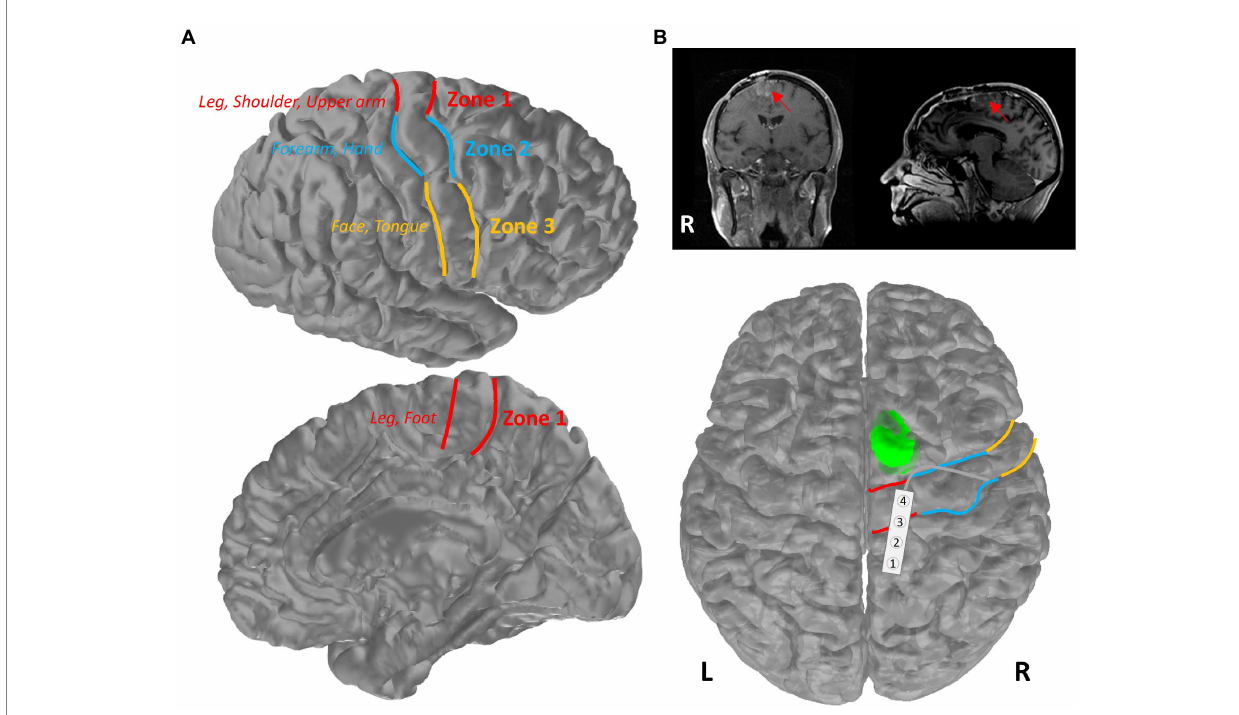
FIGURE 1 Primary motor cortex of the brain. (A) Schematic of Zones 1–3 in the primary motor cortex. Patients were separated into three groups based on the mapping location within these three zones (red: Zone 1; blue: Zone 2; yellow: Zone 3). (B) Illustration of the tumor location of the patient in the highlighted case. Patient’s pre-operative MR images were presented in coronal and sagittal views, with a red arrow pointing toward the tumor. The tumor is shown in green on an averaged brain atlas surface. Zones 1–3 were delineated with the corresponding colors as shown in (A) . The strip electrode used for functional mapping was placed over the primary motor and sensory areas in Zone